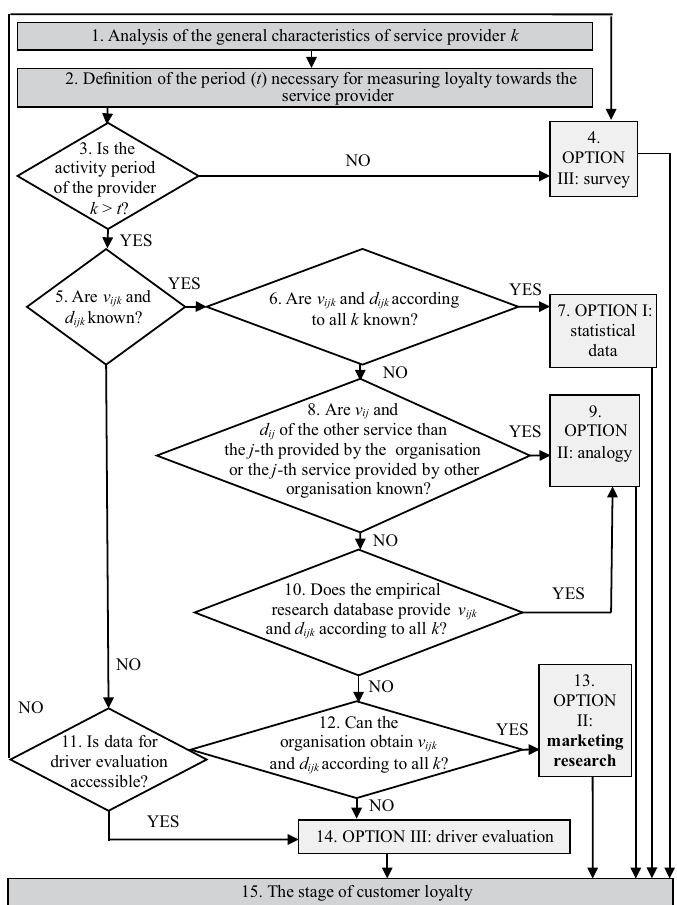
Fig. 5. Algorithm for measuring customer loyalty towards a service